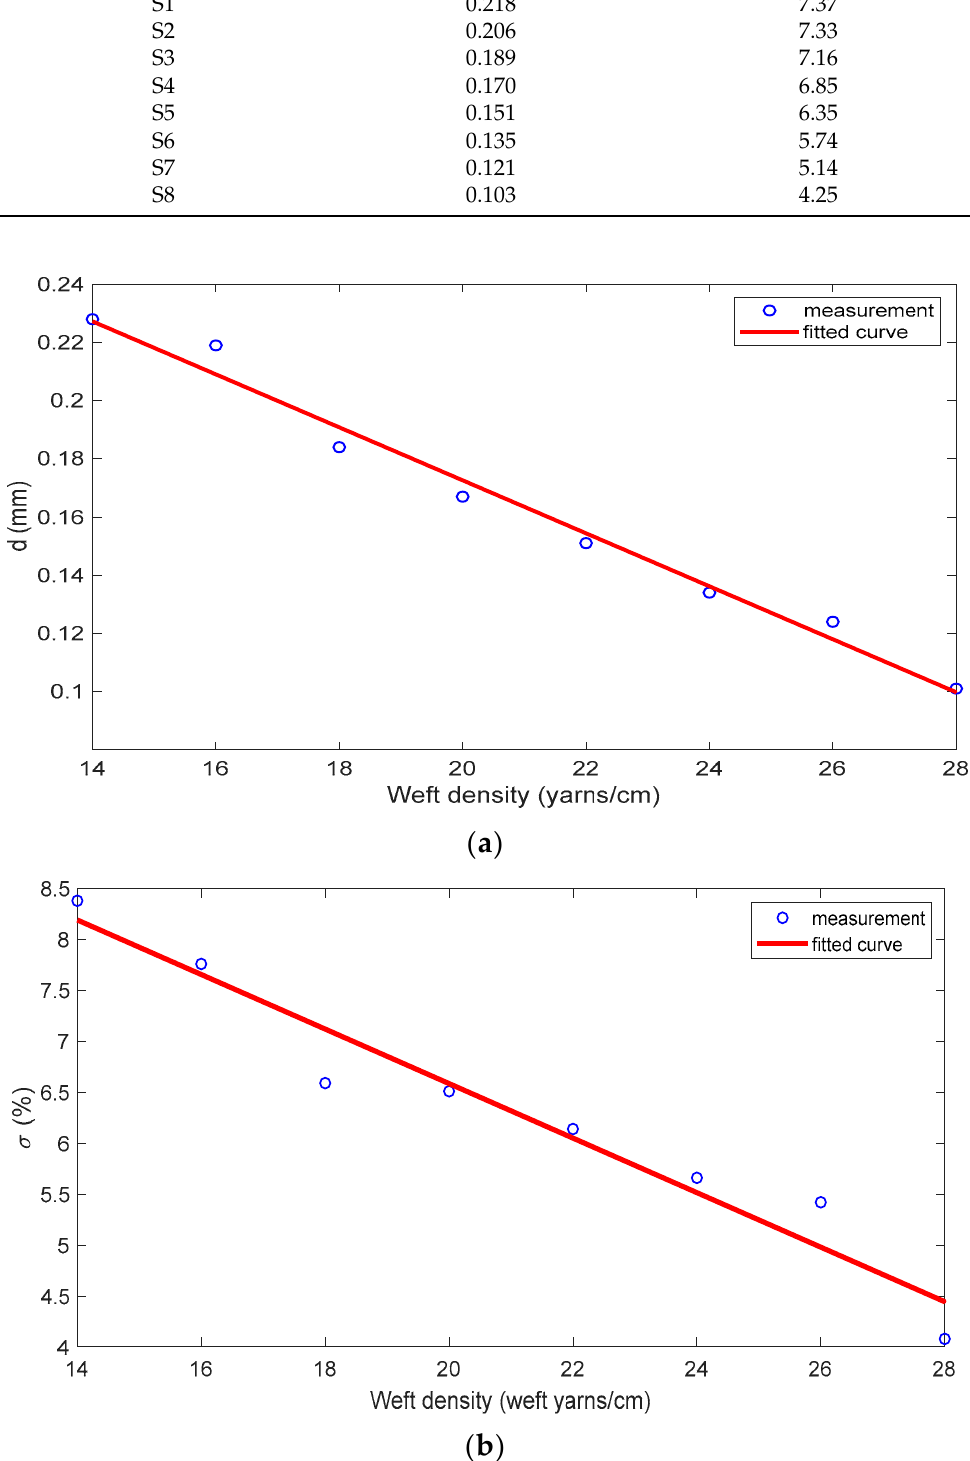
Figure 7. ( a ) Linear regression fitting weft density and hole diameter; ( b ) Linear regression fitting weft density and perforation ratio